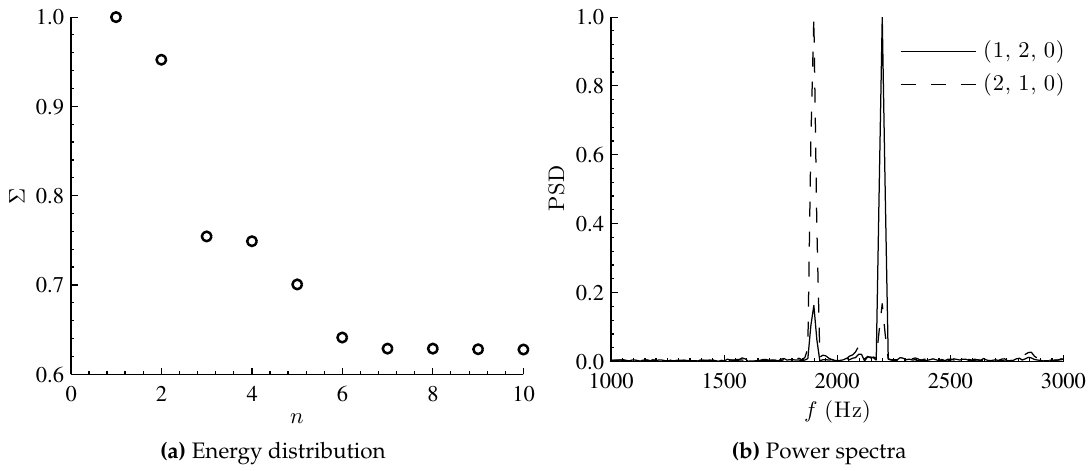
Figure 7. Energy distribution and power spectra of temporal proper orthogonal decomposition (POD) modes for combined modeshapes ( 2,1,0 ) and ( 1,2,0 )